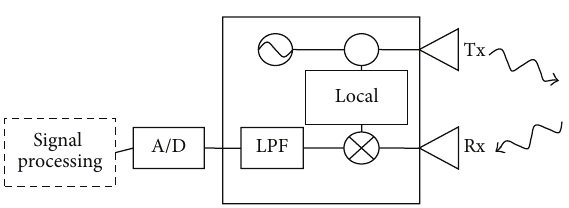
Figure 2: Schematic diagram of the experiment.